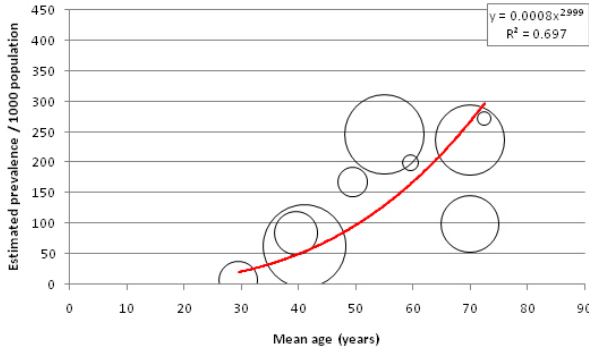
Figure 17. Relationship between crude prevalence of type 2 diabetes and age in Southern Asia based on the studies using OGTT only in their case definition. OGTT –oral glucose tolerance test.